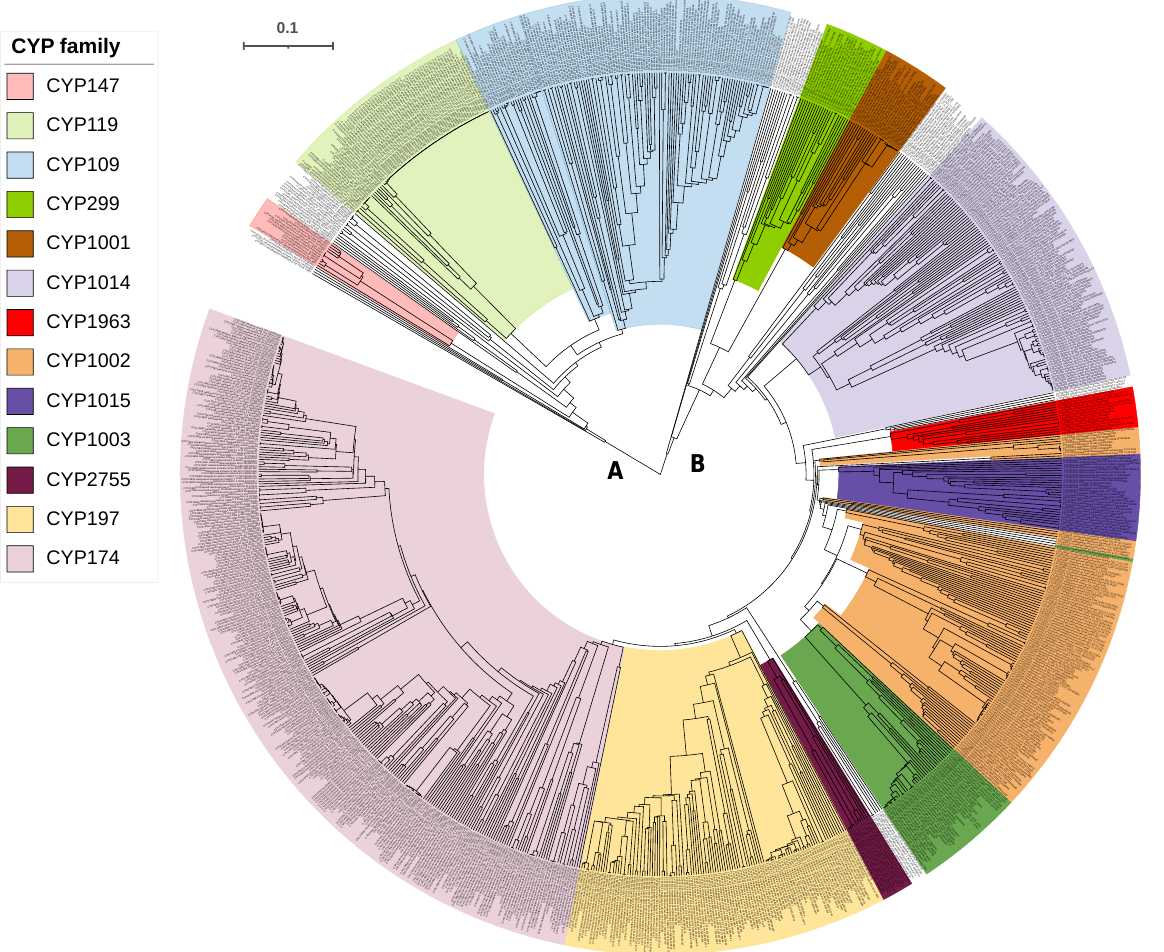
Figure 1. Phylogenetic analysis of archaeal P450s. Major P450 families and the P450 families that are common between bacteria and archaea are displayed in different colors. The tree branch length is indicated as the scale bar in the upper left corner. A and B represent the two main branches of the tree. The tree is constructed with P450 sequences presented in Table S1 by the alignment of MAFFT v6.864 [36] and inferred by the Trex web server